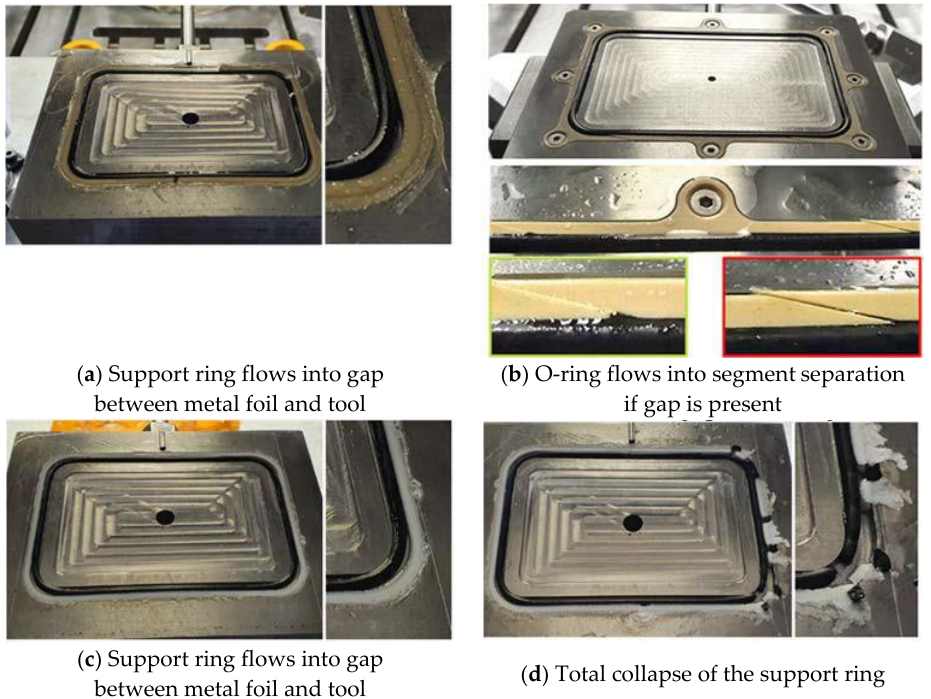
Figure 8. Sealing-failure cases (O-ring with support ring): ( a ) one-piece milled PEEK support ring, ( b ) multi-piece milled PEEK support ring, ( c , d ) one-piece 3D-printed support ring.